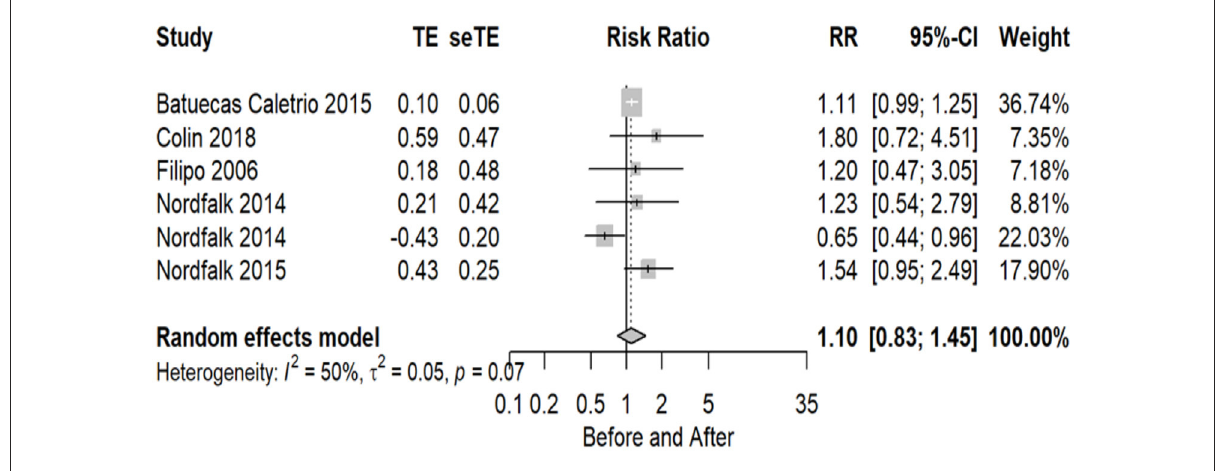
FIGURE6 Forest plot (showing relative effect sizes) for the VNG test.